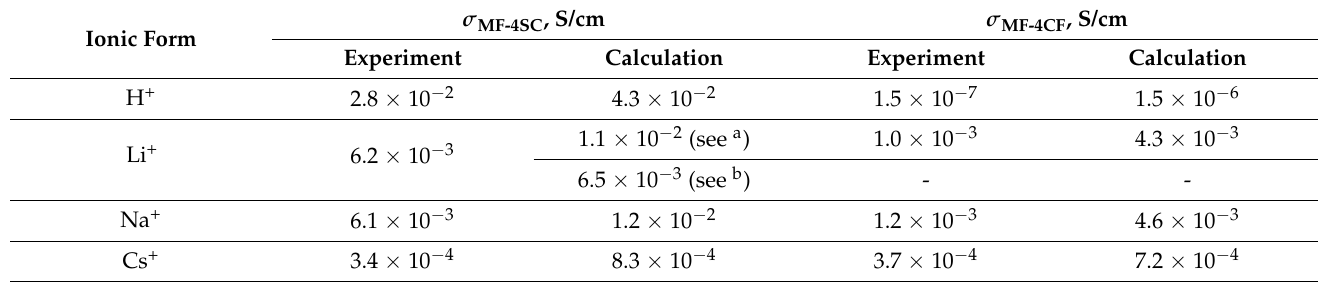
Table 5. Ionic conductivities calculated from the diffusion coefficients of water and Li + cations and measured for MF-4SC and F-4CF membranes in different ionic forms at a relative humidity of 90% (Adapted from [38]).